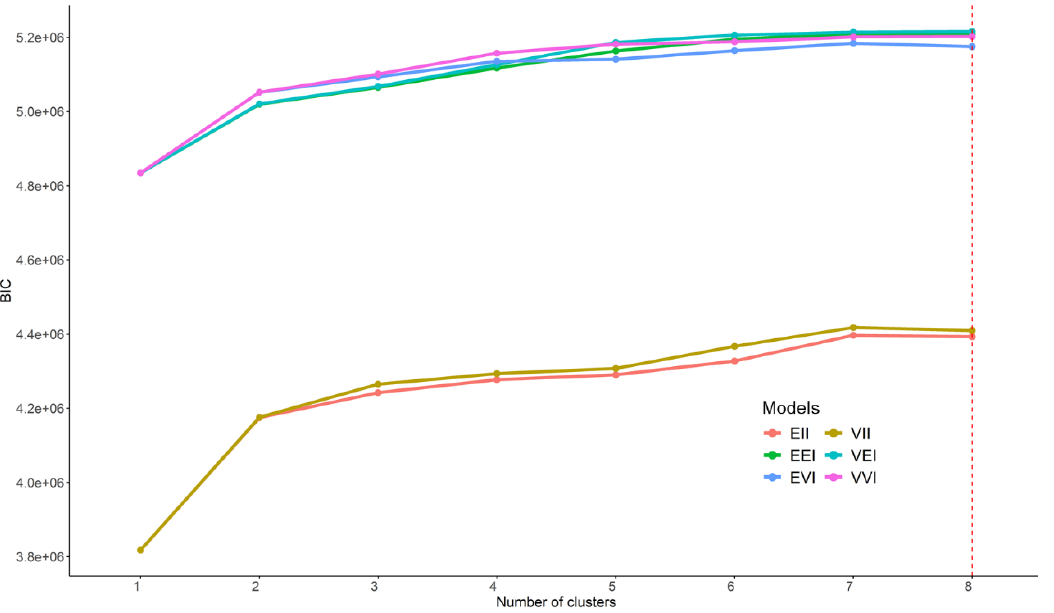
Figure 1. BIC value obtained as a function of the number of clusters per Gaussian mixture model resulting from the model-based clustering analysis. The spectroscopic data matrix of the unadulterated samples was used for the analysis, i.e., D 76×4190 .